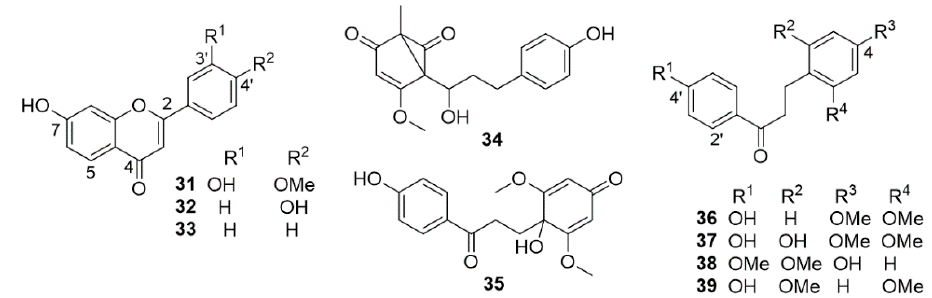
Figure 8. Selected flavones and dihydrochalcone derivatives from D. cochinchinensis red resin. Homoisoflavones :